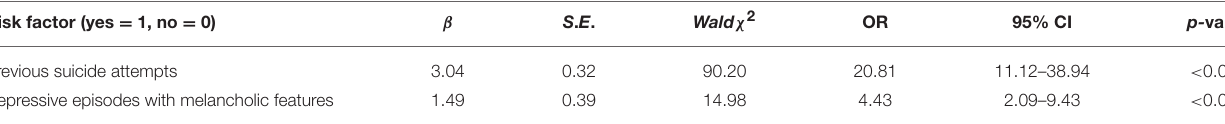
TABLE 2 | Multiple logistic regression analysis of the risk factors for recent suicide attempts in MDD patients. Risk factor (yes = 1, no = 0) β S . E . Wald χ 2 OR 95% CI p- value Previous suicide attempts